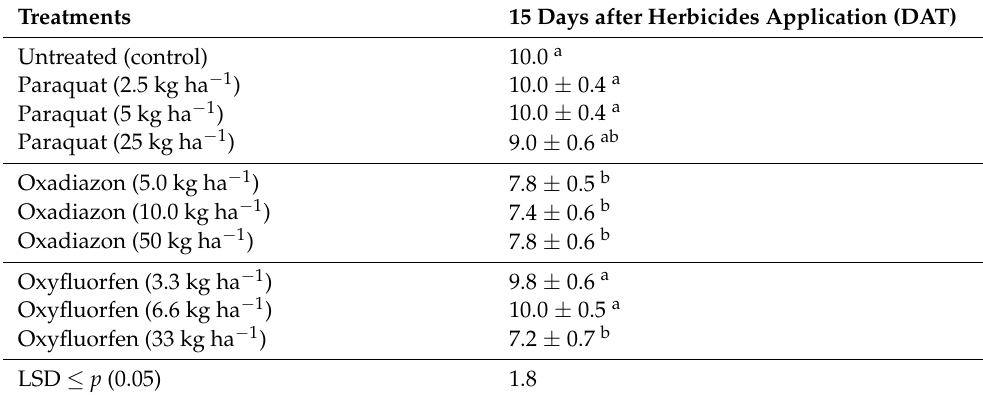
Table 3. Visual estimations of foliage-applied herbicides’ effects on Conyza bonariensis of Tal-al-Ramel population (P1) control at 15 days after herbicides application (DAT).